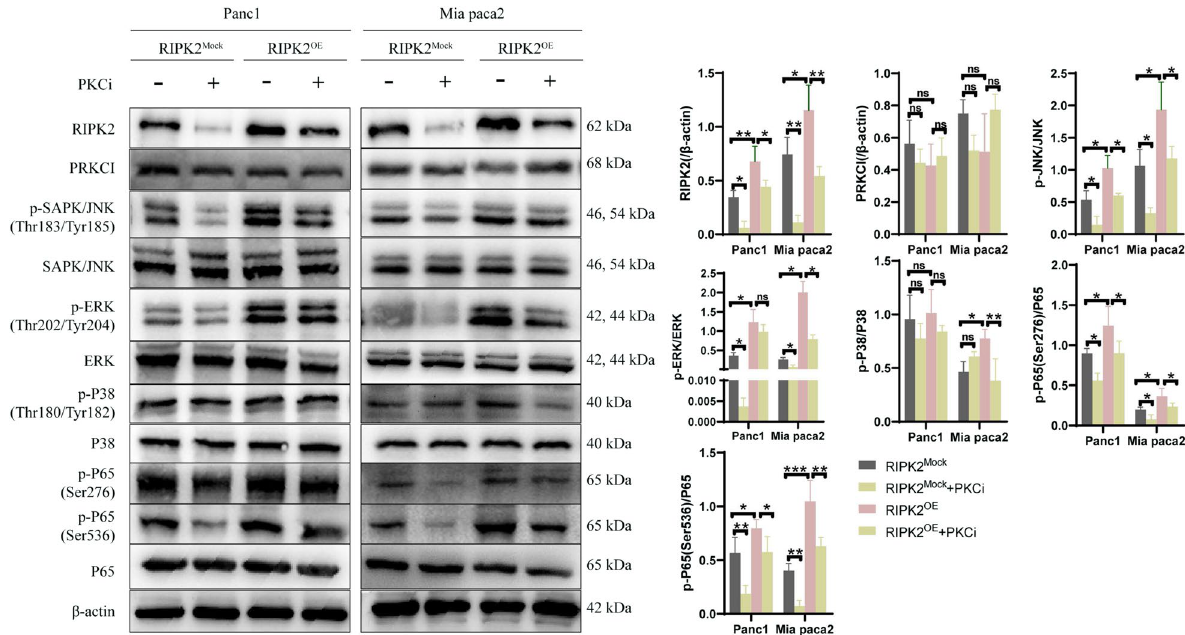
Fig. 8 PKC iota inhibition affected the expression of RIPK2 and the phosphorylation of NF‑κB, JNK and ERK. * p < 0.05, ** p < 0.01, *** p < 0.001, ns not